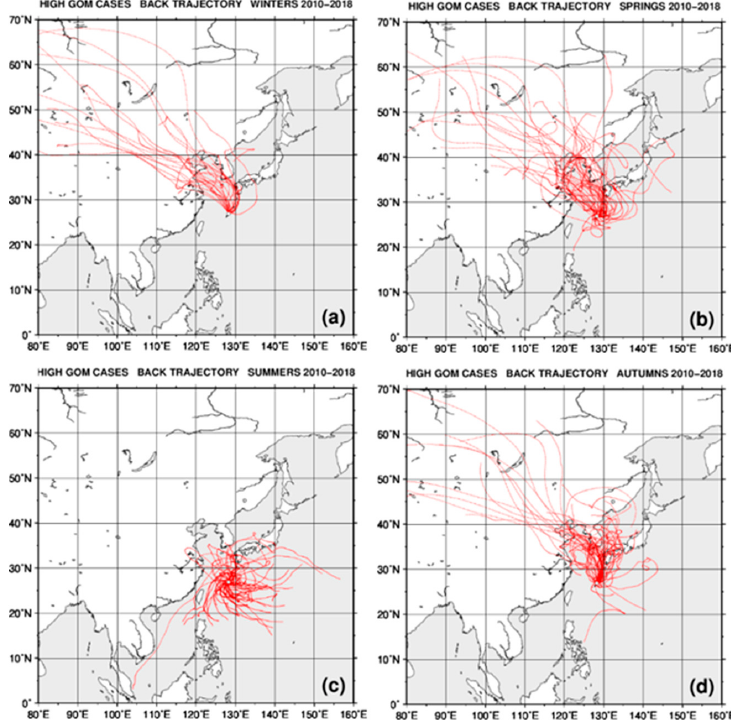
Figure 6. Seasonal changes in the pathway of the air mass arriving at Cape Hedo when GOM pollution events were observed in ( a ) winter, ( b ) spring, ( c ) summer, and ( d ) fall.